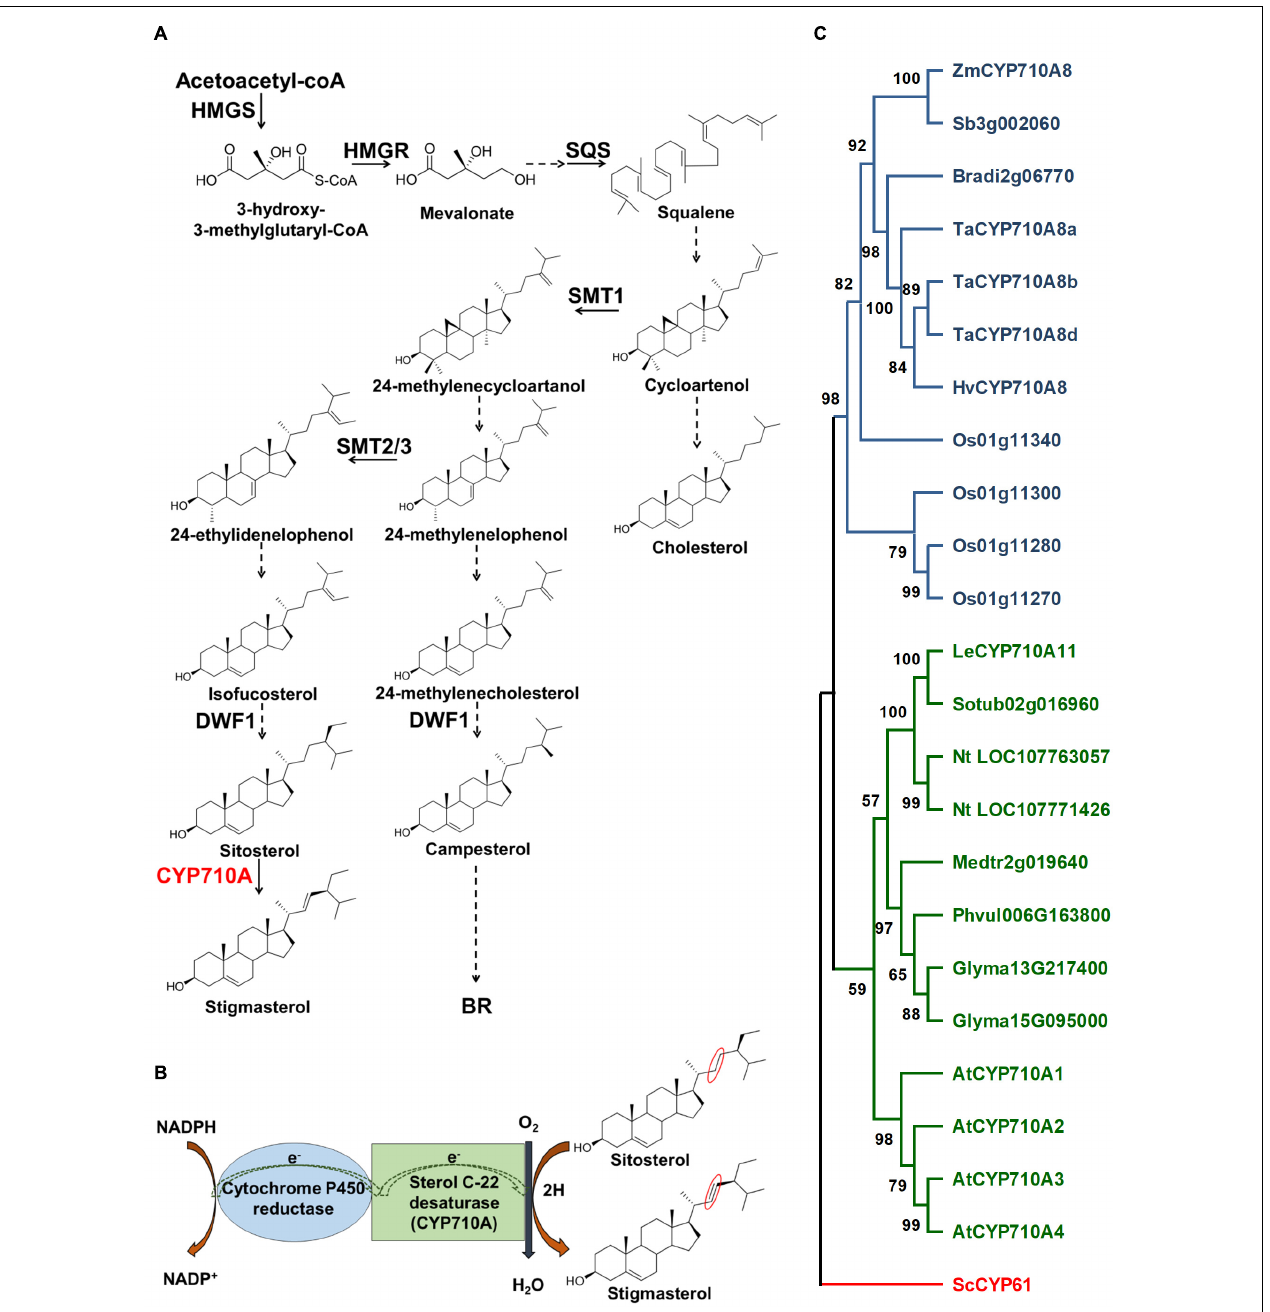
FIGURE 1 | Stigmasterol biosynthesis and the phylogenetic relationship of CYP710A-like homologs. (A) The biosynthetic pathway of plant sterols leading to stigmasterol. Stigmasterol synthesis starts from acetate followed by a series of steps. Plants produce a mixture of sterols, in addition to stigmasterol, including campesterol (24-methyl) and sitosterol. The enzyme, sterol C-22 desaturase, catalyzes the conversion of sitosterol to stigmasterol. Campesterol is the preferred precursor of brassinosteroids (BR). Dashed arrows indicate multiple steps and solid arrows denote single step in the pathway.